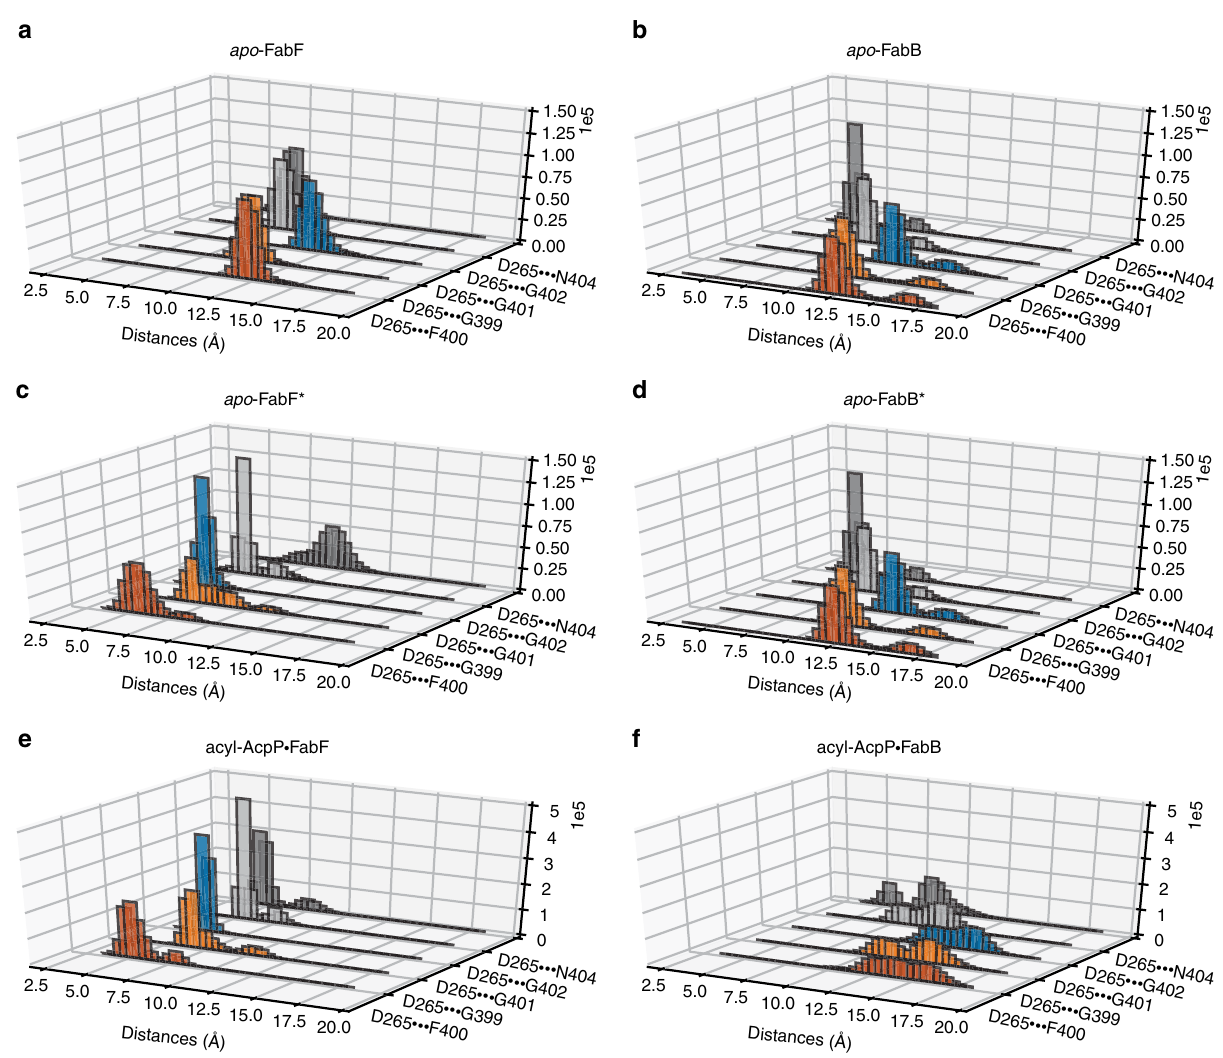
Fig. 9 Analysis of the fl uctuations of inter-loop hydrogen bonding networks. Histograms showing the distances between the hydrogen-bond donating Asp265 and highly conversed (hydrogen-bonding accepting) resudes, Gly399, Phe400, Gly401, Gly402, and Asn404 sampled computationally. Histograms of these distances sampled in molecular dynamics (MD) simulations of a apo -FabF, b apo -FabB, c apo -FabF*, d apo -FabB*, e acyl-AcpP·FabF, and f acyl-AcpP·FabB,